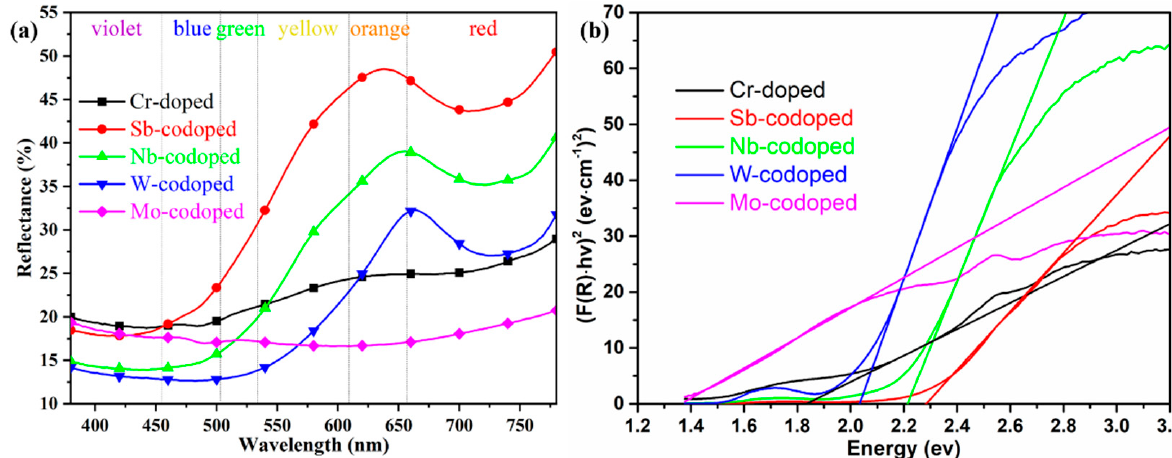
Figure 4. UV–Vis reflection spectra ( a ) and derived bandgap ( b ) of 10% Cr-doped TiO 2 pigments with and without 10% counterions. Table 2. Intrinsic absorption bandgap (E g ) and wavelength ( λ i ) of the doped TiO 2 pigments . Dopant Elements